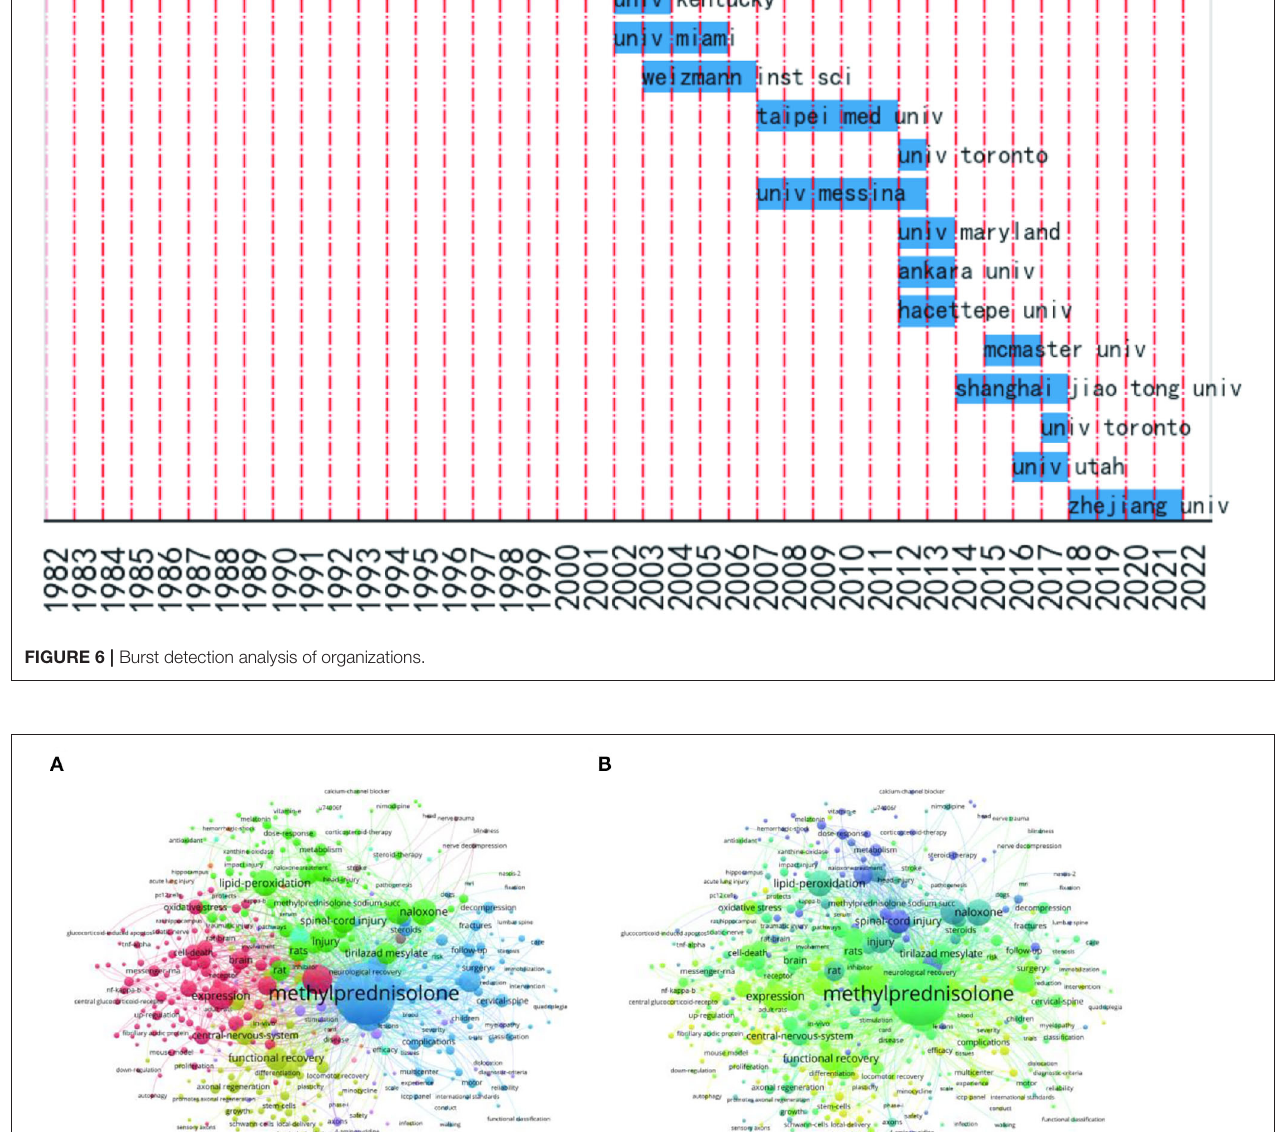
Frontiers in Public Health |